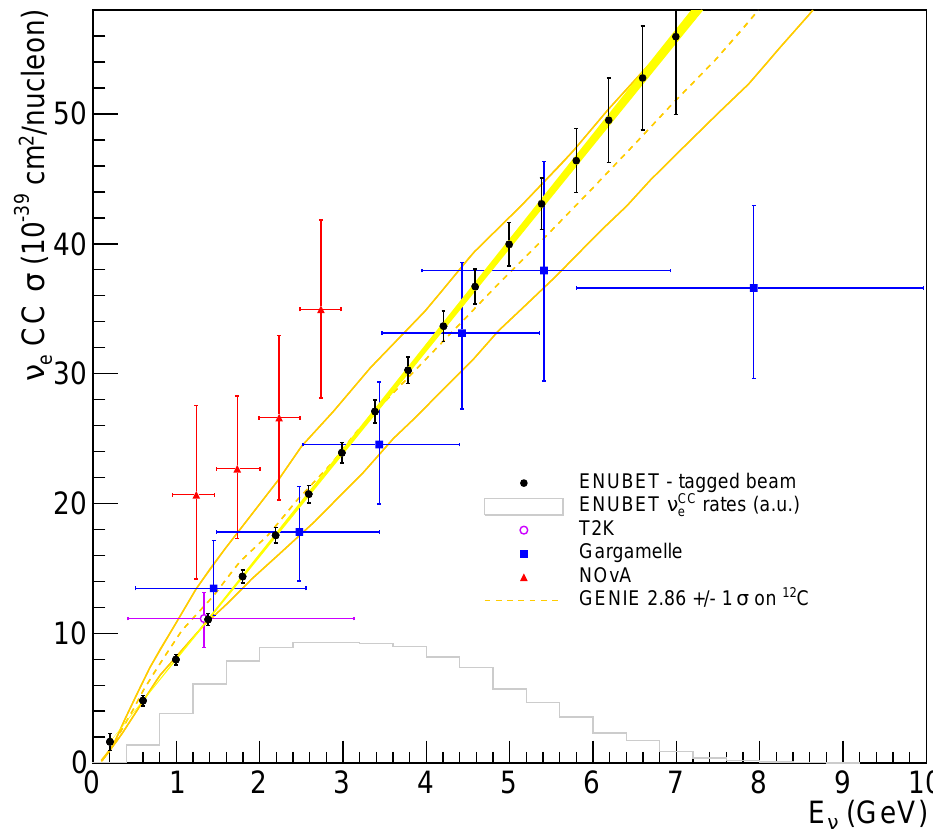
Figure 17. Impact of ENUBET data on the ν e cross-section compared with current measurements from T2K, NO ν Aand Gargamelle. Theory expectations (dashed orange line) and the corresponding systematics (region between the orange lines) are shown together with the overall systematic budget of ENUBET (yellow band). The gray line shows the energy spectrum (in a.u.) of the ENUBET beamline tuned for the DUNE energy